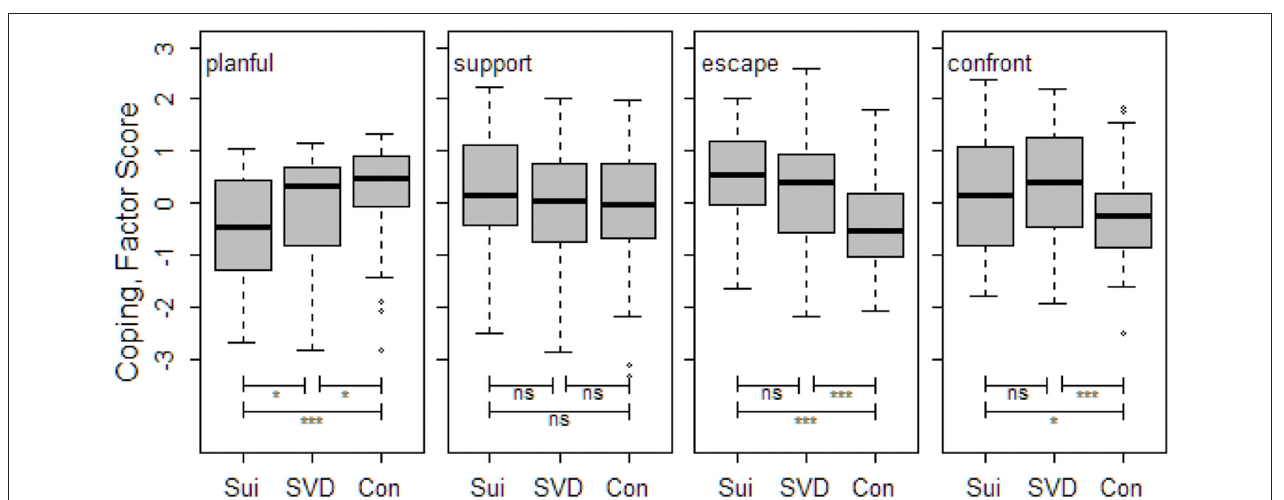
FIGURE 2 | Between-group differences in coping styles (median factor score, interquartile range, and range) for the four factors, and significance levels. *** p < 0.001, * p < 0.05, ns, non-significant; Sui, suicide group; SVD, sudden violent death group; Con, control